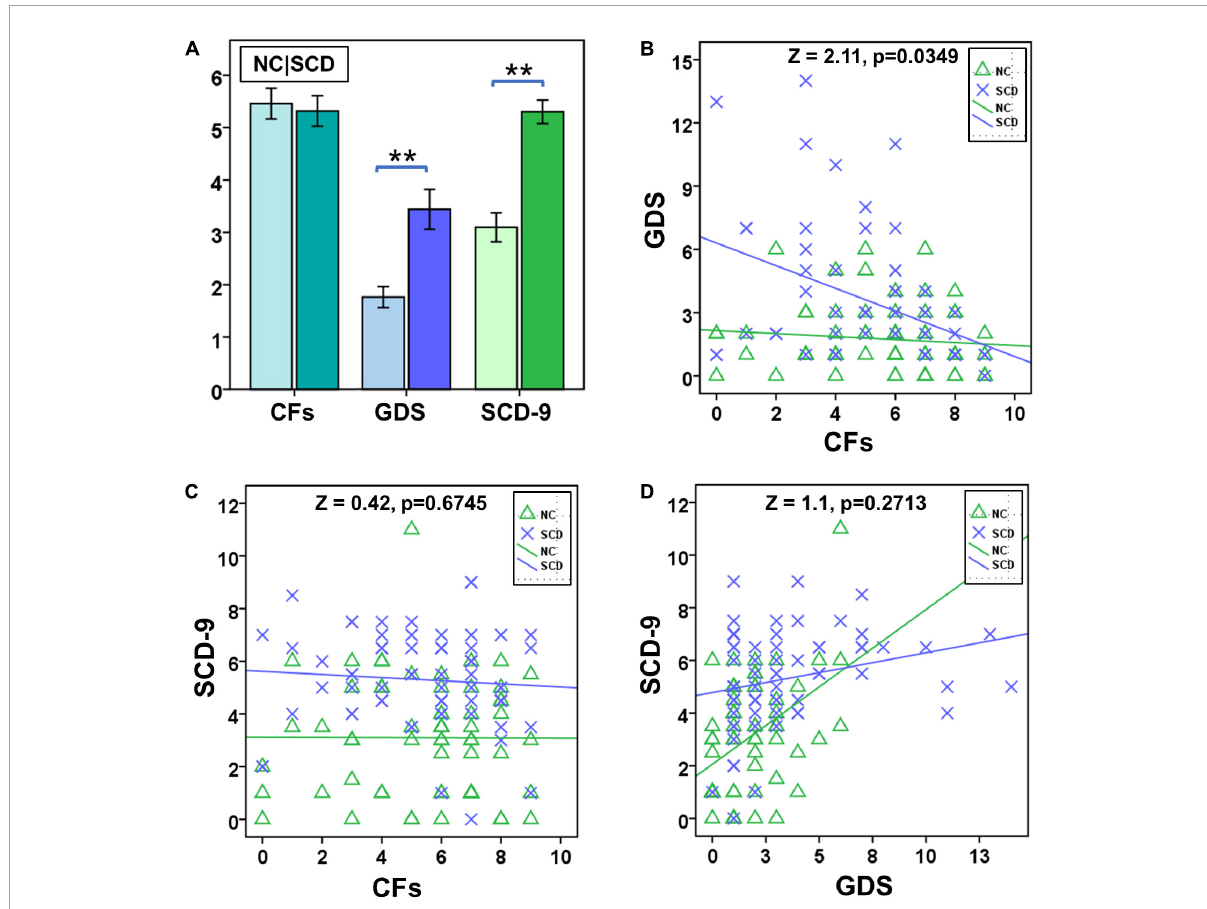
FIGURE1 Statistical analysis of number of close friends (CFs), geriatric depression scale (GDS), and subjective cognitive decline questionnaire of 9-item (SCD-9) between NC and SCD. (A) Between NC (the left one) and SCD (the right one), number of CFs exhibited no significant difference, whereas GDS and SCD-9 did. (B) The factor CF was significantly correlated with GDS in the SCD group. (C) The NC and SCD groups exhibited no significant correlation between number of CFs and SCD-9. (D) The NC and SCD groups exhibited significant correlation between GDS and SCD-9. ** p <